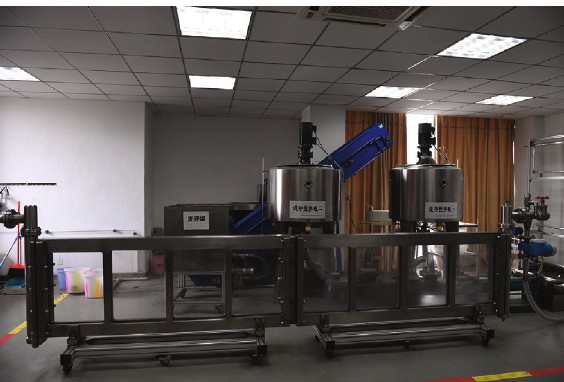
Figure 3: Experimental device for visualization of proppant fl ow state in proppant-supported